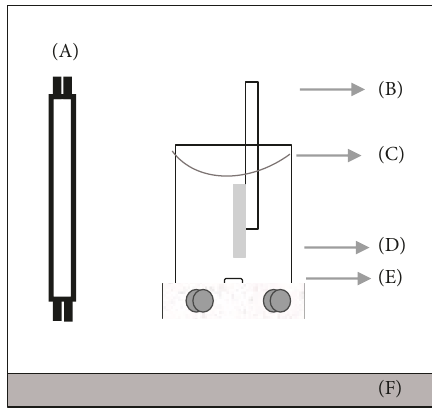
Figure 1: General scheme of photoreactor: (A) UV light source, (B) holder, (C) the beaker container and methylene blue solution, (D) photocatalyst thin fi lm, (E) magnetic stirring, and (F) INOX